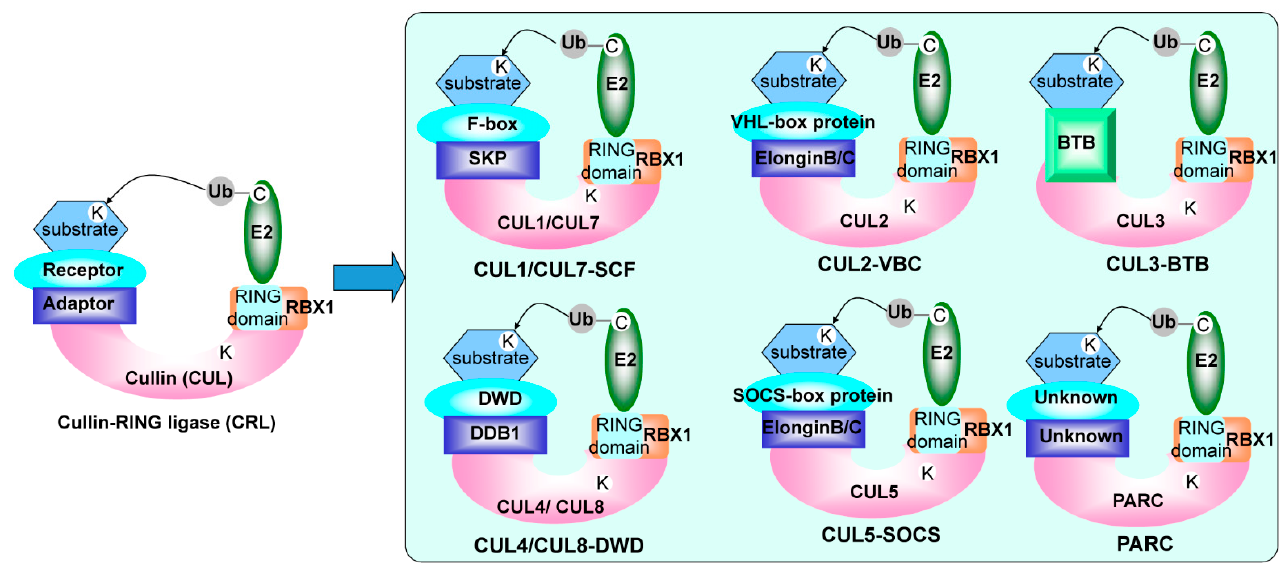
Figure 1. Diagram of cullin-RING ligases [17]. The C in the E2 presents the active site cysteine that binds to activated ubiquitin (Ub). The K in substrates and cullins indicates the acceptor sites for ubiquitin or Nedd8, respectively.